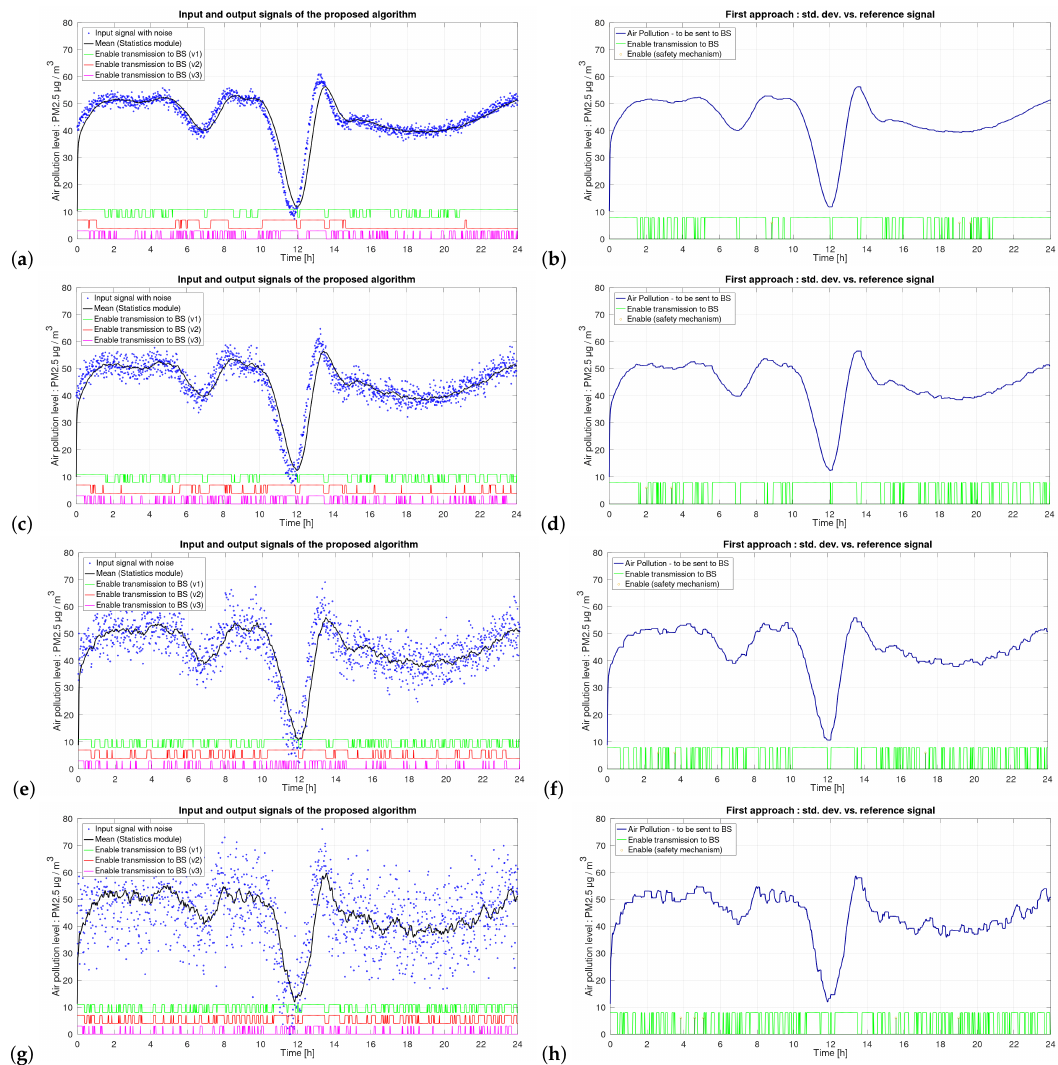
Figure 10. Simulation results for Approach 1, for different noise levels and the values of K and N lpf2 of 16. ( a ) Input, mean, and EN signals for noise amplitude of c. 6 PM2.5 µ g/m 3 (10%); ( b ) Sensor output signal sent to BS; ( c ) Input, mean, and EN signals for noise amplitude of c. 12 PM2.5 µ g/m 3 (20%); ( d ) Sensor output signal sent to BS; ( e ) Input, mean, and EN signals for noise amplitude of c. 24 PM2.5 µ g/m 3 (40%); ( f ) Sensor output signal sent to BS; ( g ) Input, mean, and EN signals for noise amplitude of c. 48 PM2.5 µ g/m 3 (80%); ( h ) Sensor output signal sent to